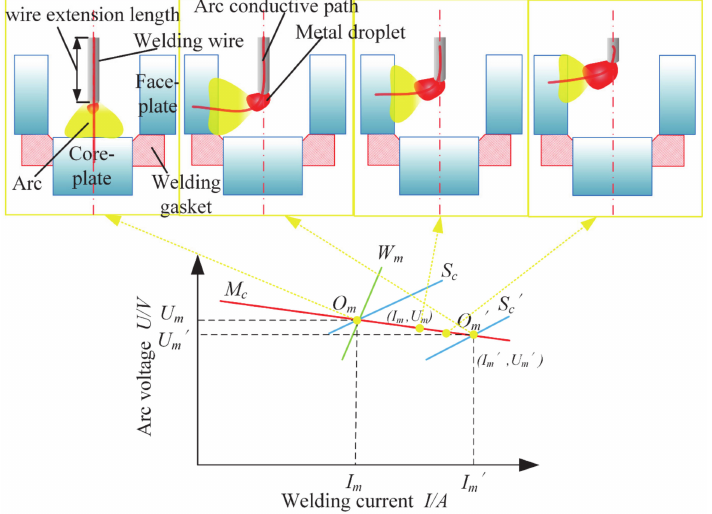
Figure 8. The arc burning position climbing up phenomenon (APCP) process in ultra-narrow gap groove. M c is the curve of external characteristic of the welding machine, W m is the curve showing that the wire melting rate equals to the wire feeding speed, S c is the curve of arc static characteristic, S c´ is the curve of short arc static characteristic, O m and O m´ are the balance